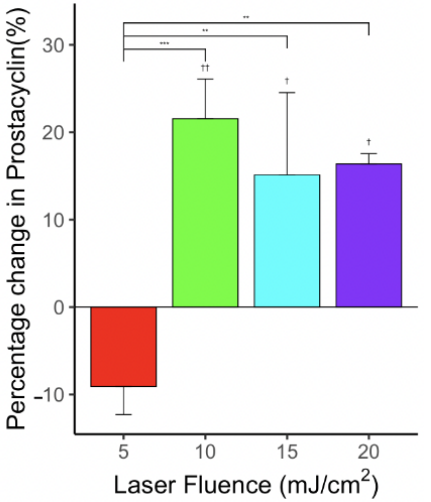
Figure 9. Effect of laser on PGI 2 levels for various laser fluences—5, 10, 15, and 20 mJ/cm 2 —showing statistically significant changes in PGI 2 levels compared to control. n = 6 for each group. “**” indicates statistical significance between treatment groups with p < 0.01. “***” indicates statistical significance between groups with p < 0.001. “†” indicates statistical significance between control and treatment group p < 0.05. “††” indicates statistical significance between control and treatment group p < 0.01.